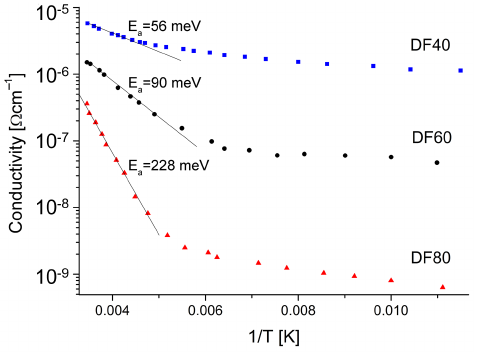
Figure 6. Electrical conduction variation with the inverse temperature for the studied diamond